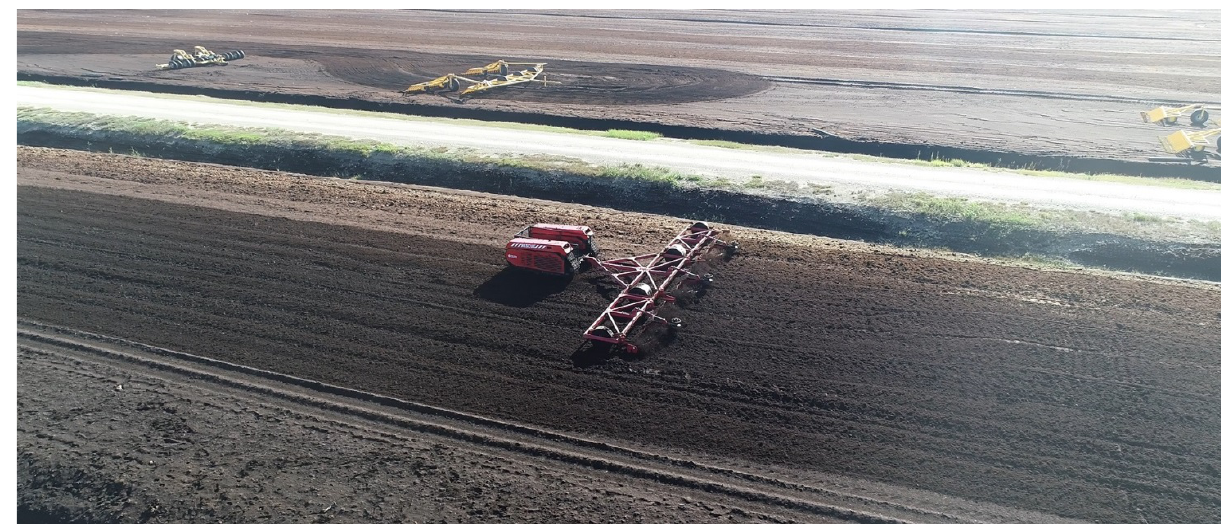
Figure 3. The Multiscope UGV towing a passive